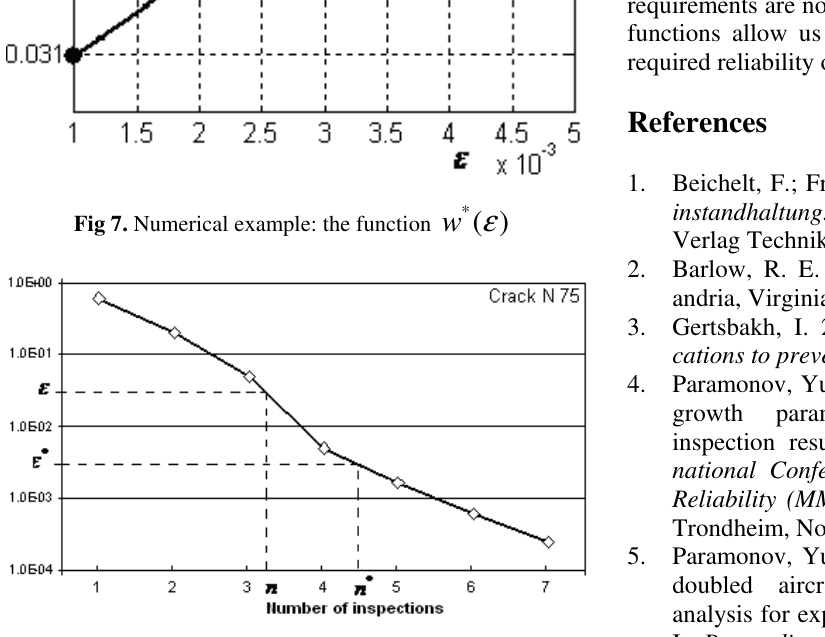
Fig 8. Numerical example: determining required number of